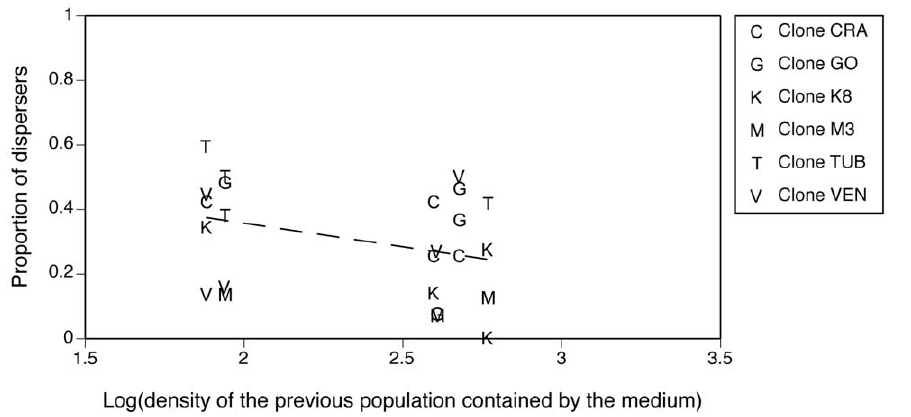
Figure 2. Relationship between the donor population density (i.e. density of the population previously contained by the culture medium) and the proportion of dispersing cells (experiment 1). In this experiment, we manipulated the nature of the medium but not the cell concentration. Populations were exposed to medium from donor populations of higher or lower density. The non-significant relationship does not support the chemical mediation hypothesis. Each point represents an independent replicate.